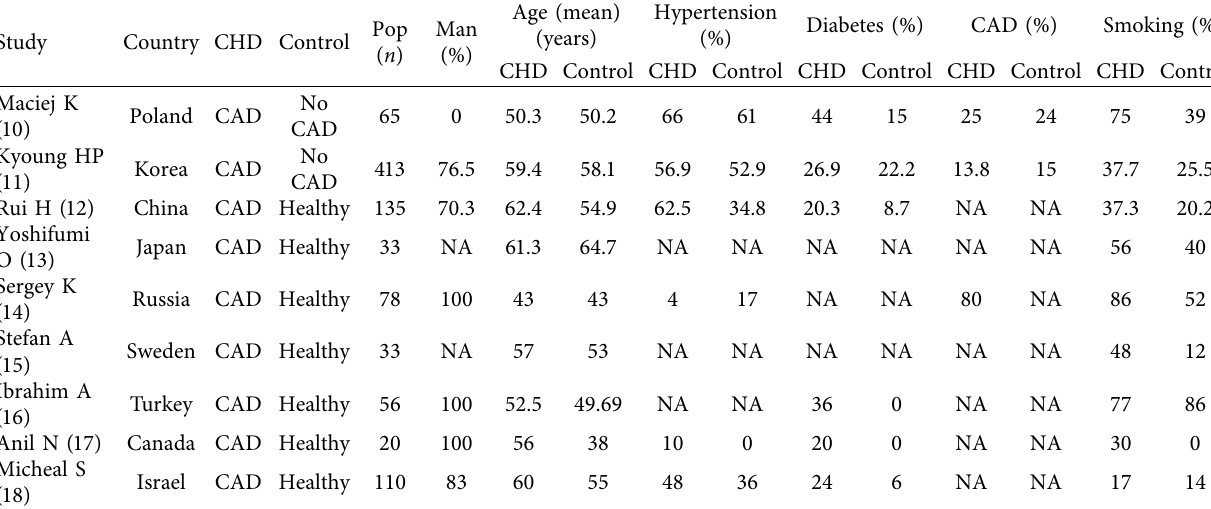
Table 1: Clinical data of patients with CHD and controls in included studies.